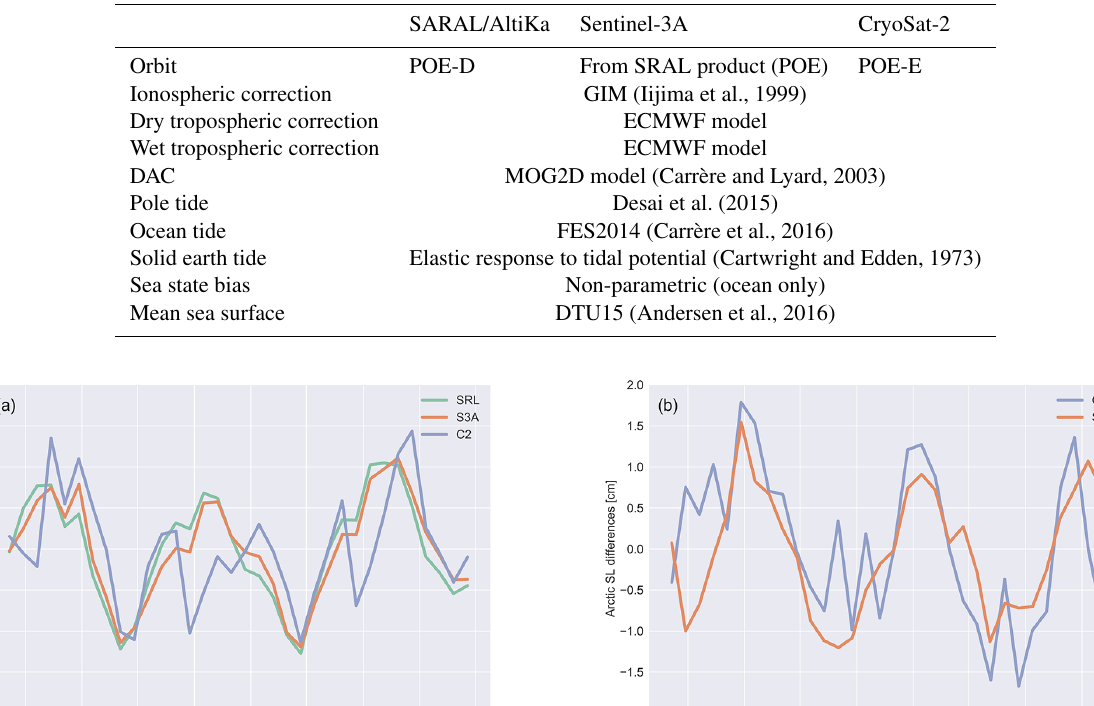
Table 3. Arctic SL altimeter standards.